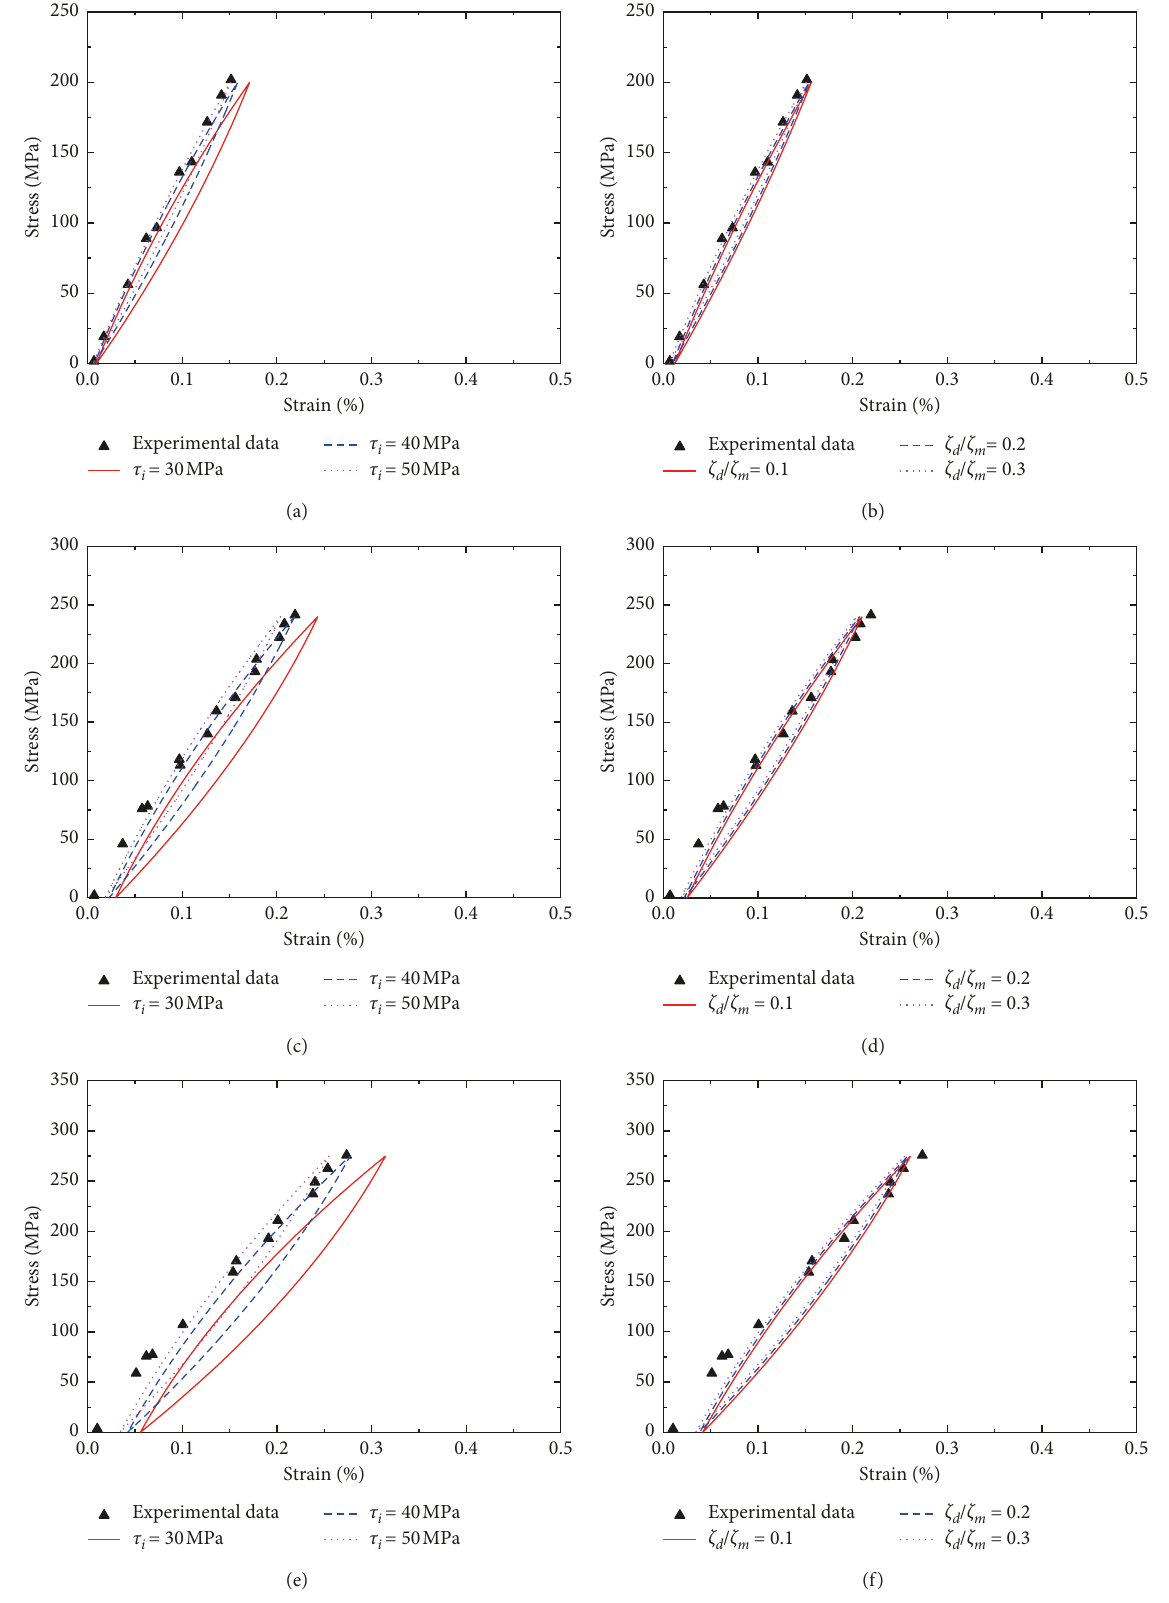
Figure 11: The experimental and predicted hysteresis loops of 2D Sylramic ™ SiC/SiC composite under (a) the fatigue peak stress of σ for different interface shear stress; (b) the fatigue peak stress of σ max � 200MPa for different interface debonding energy; (c) the fatigue peak stress of σ max � 240MPafordifferentinterfaceshearstress;(d)thefatiguepeakstressof σ max � 240MPafordifferentinterfacedebondingenergy;(e)thefatigue peak stress of σ max � 275MPa for different interface shear stress; (f) the fatigue peak stress of σ max � 275MPa for different interface debonding